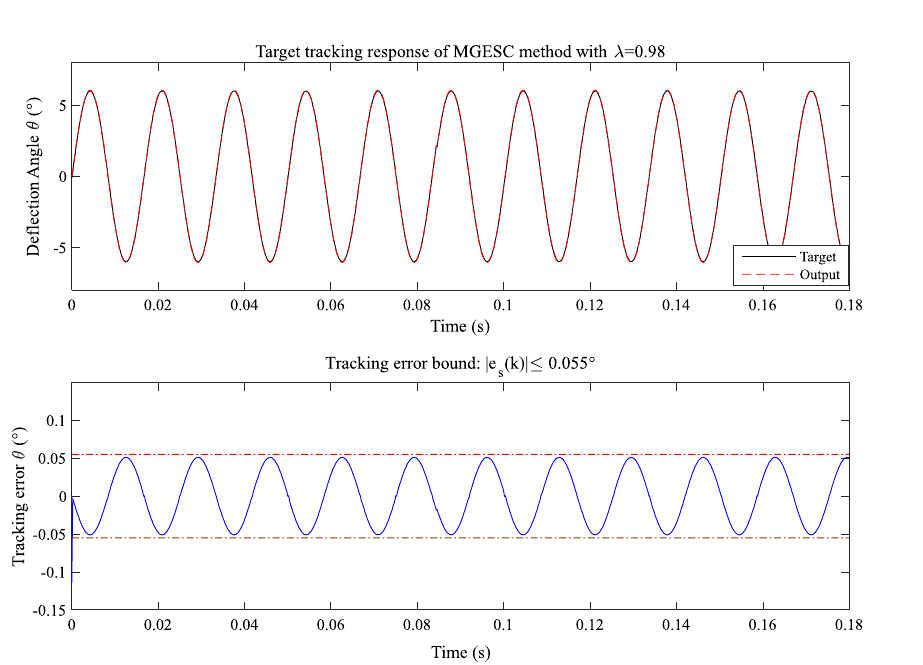
Figure 16. Tracking performance of the MGESC with fixed λ =